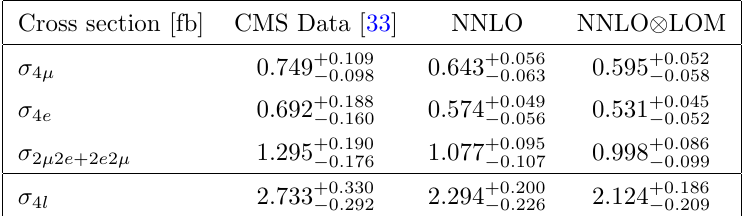
(cid:31) dt =137.1 fb − 1 ] (centre) and ATLAS I L